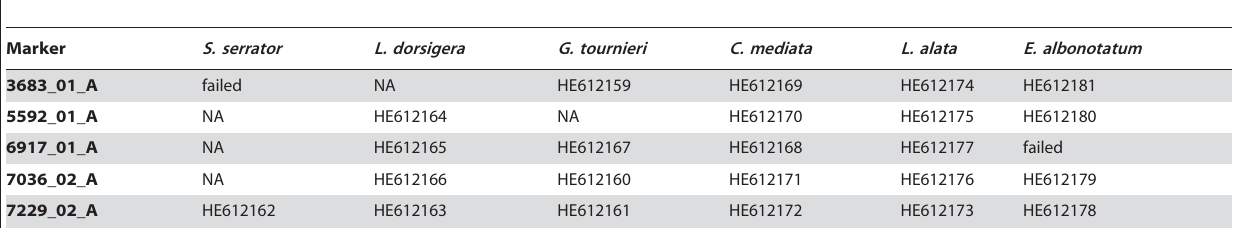
Table 5. European Nucleotide Archive accession numbers for all sequences generated from primer testing.